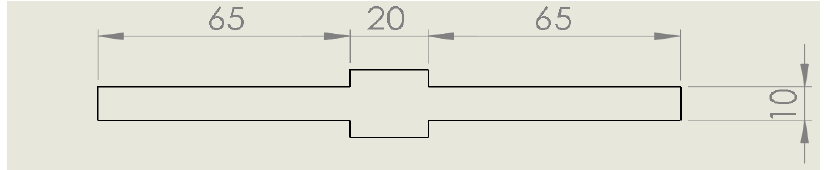
Figure 4. Shrinkage test dimensions (mm). Created by Kim Pickering and David Stoof.